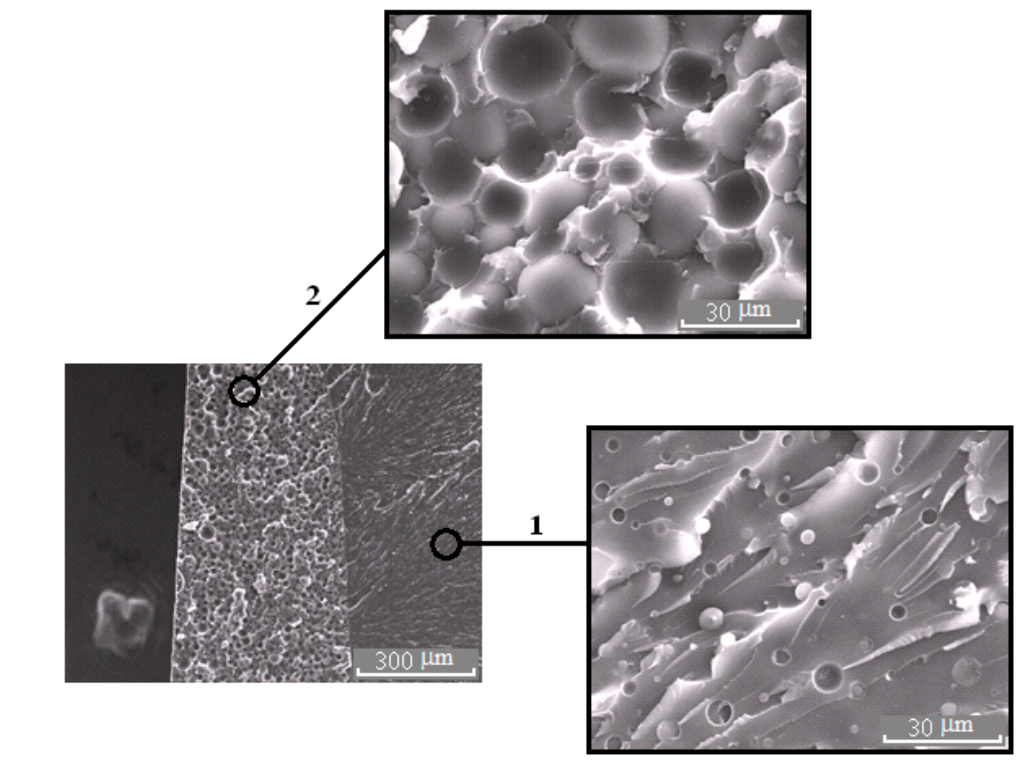
Figure 8. Morphology of the PES–EO mixture at φ PES 15 wt.%.